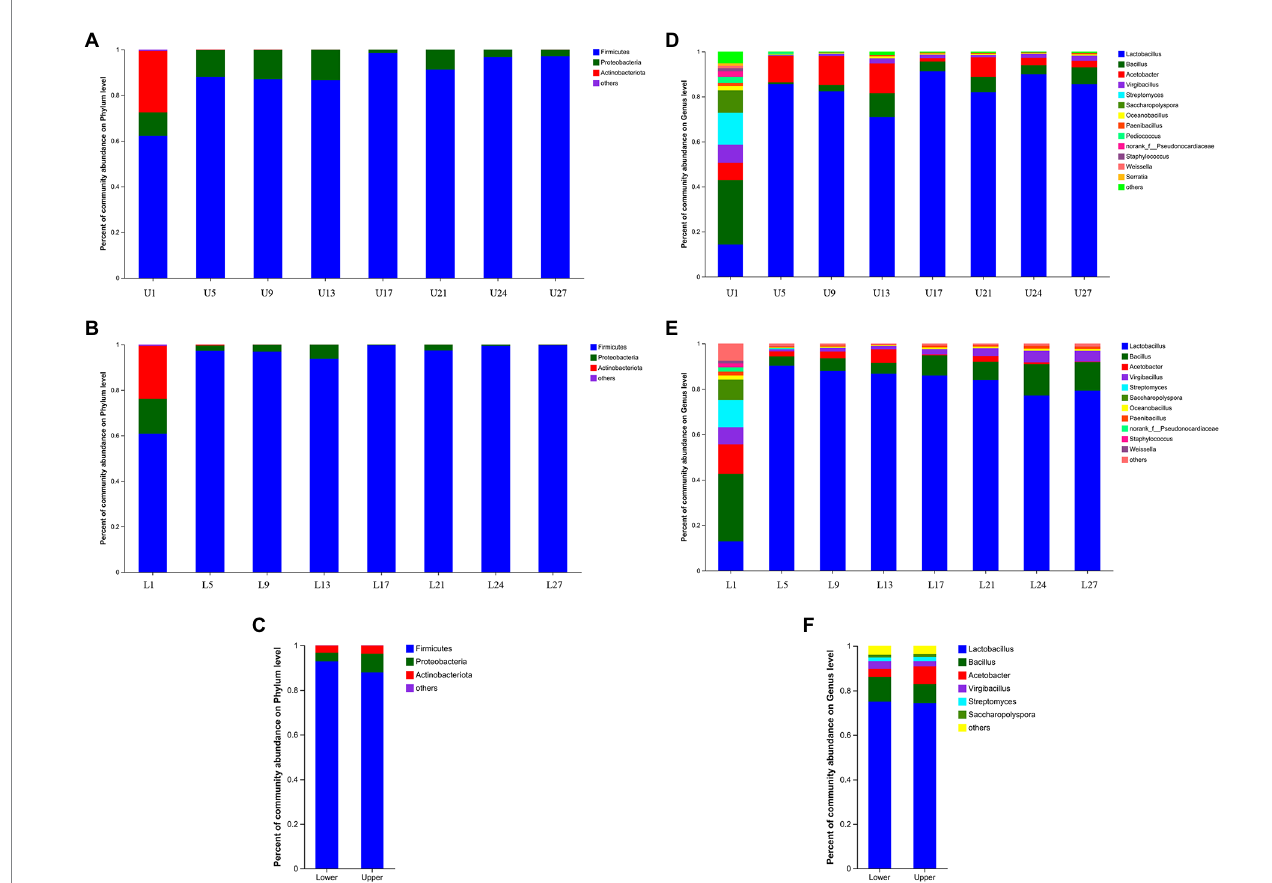
FIGURE 2 Relative abundance of the bacterial community structure. (A) The upper layer at phylum level, (B) the lower layer at phylum level, (C) the upper and lower layers at phylum level, (D) the upper layer at genus level, (E) the lower layer at genus level, (F) the upper and lower layers at genus